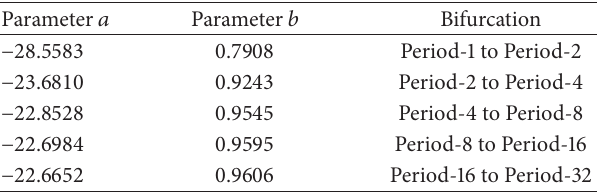
Table 2: The period-doubling cascade of system (1) versus parame- ters 𝑎 and 𝑏